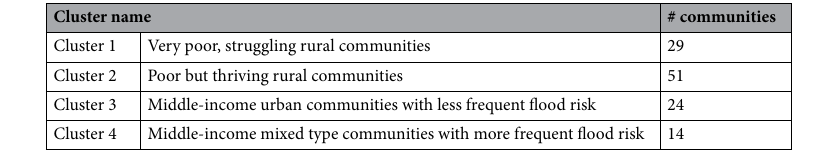
Table 2. Typology of community flood resilience 14